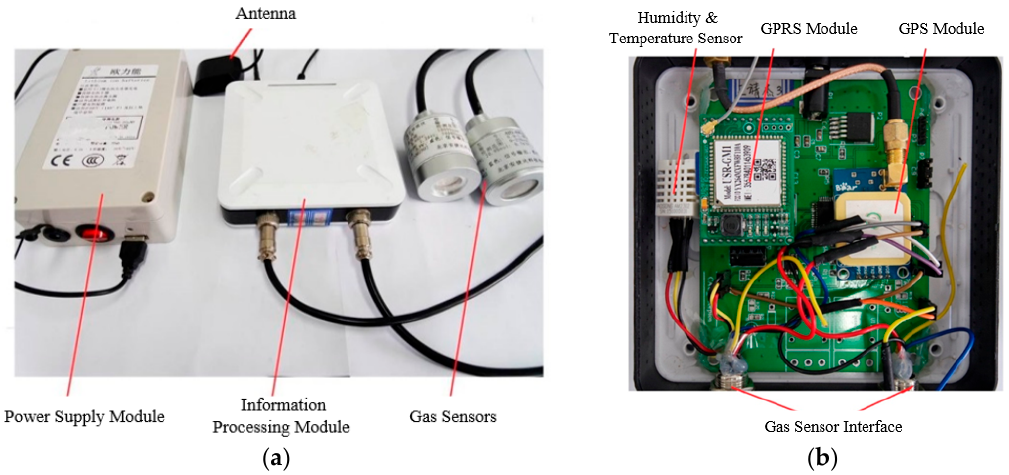
Figure 9. Photo image of hardware: ( a ) multi-parameter information acquisition and fusion device; and ( b ) the information processing module.